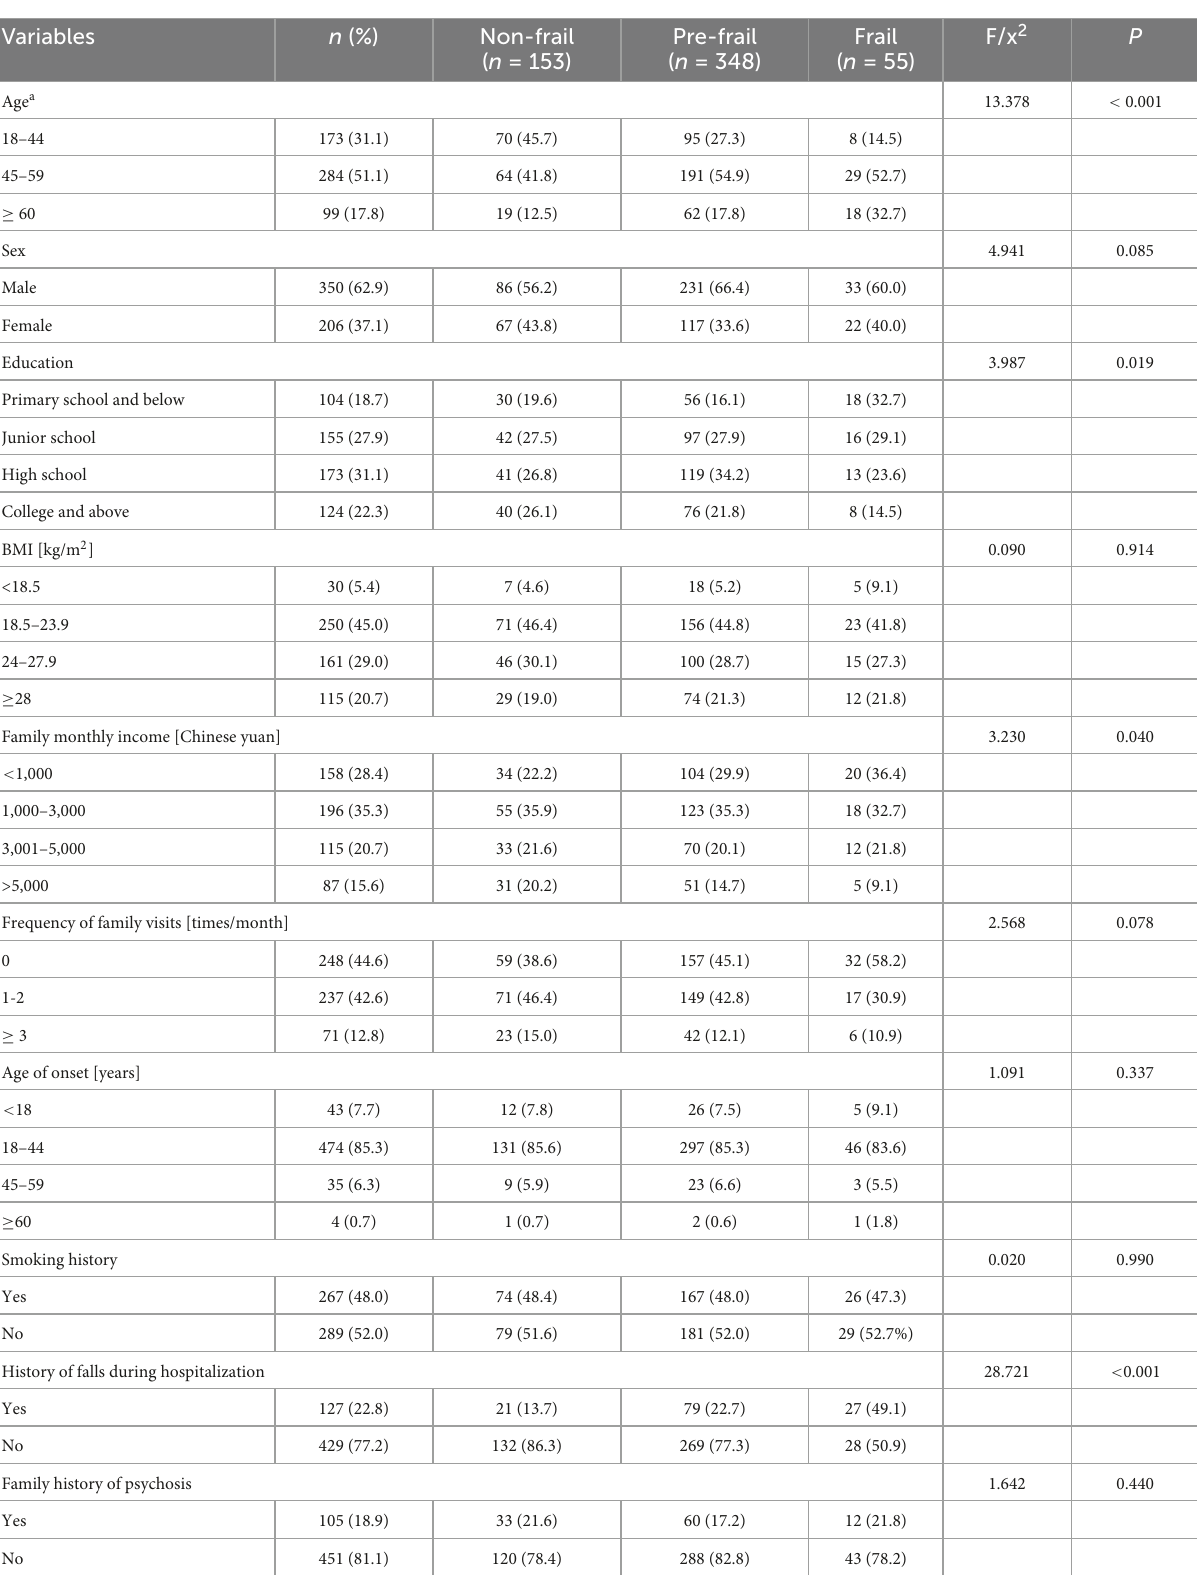
TABLE 1 Characteristics of the participants based on different frailty ( n =